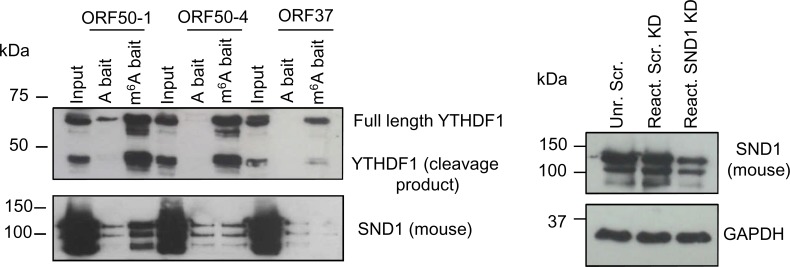
Validation of RNA affinity pull-downs.Validation of YTHDF1 and SND1 binding to the three viral baits was performed by RNA affinity using protein lysates from TREx BCBL1-Rta cells that had been reactivated for 24 hr (left panel). Detection of bound proteins was performed by western blotting, for SND1 a mouse monoclonal antibody was used. Note that YTHDF1 protein was cleaved during lytic KSHV reactivation, as this band was absent in latent cells (data not shown). The SND1 mouse antibody detects three different SND1 bands which we further confirmed to be specific by SND1 siRNA knockdown (siRNA name Hs_SND1_5 from Qiagen) in TREx BCBL1-Rta cells (right panel). Unr., unreactivated. Scr., scramble. KD., knockdown.